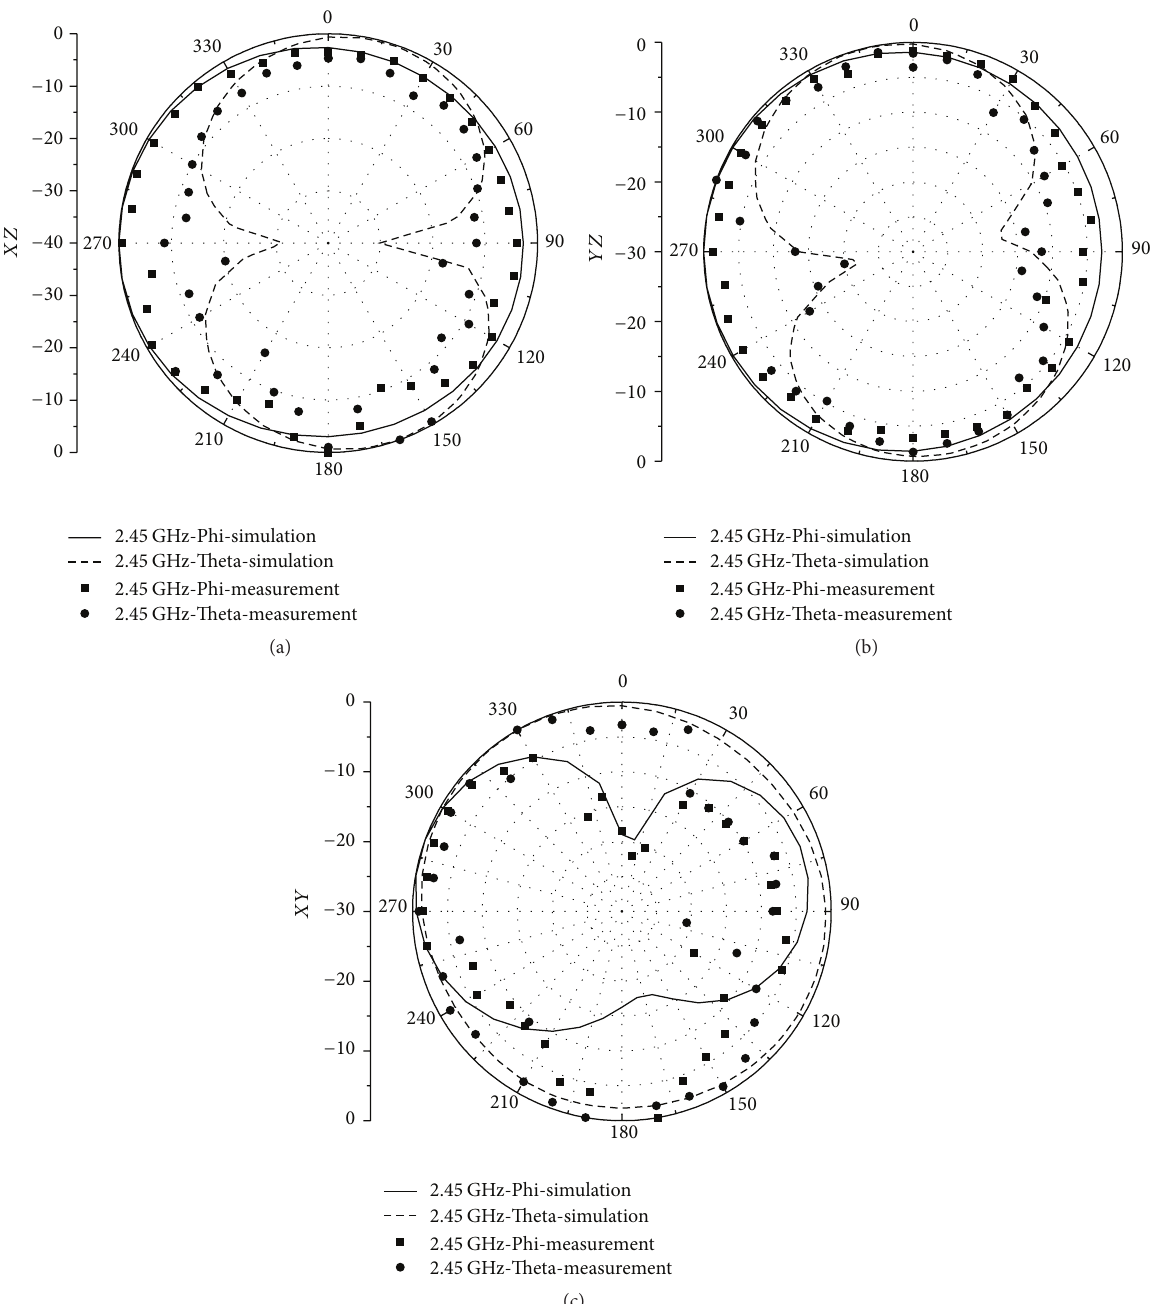
Figure 13: Radiation pattern of the proposed MIMO antenna at 2.45 GHz. (a) 𝑥𝑧 -plane, (b) 𝑦𝑧 -plane, and (c) 𝑥𝑦 -plane.